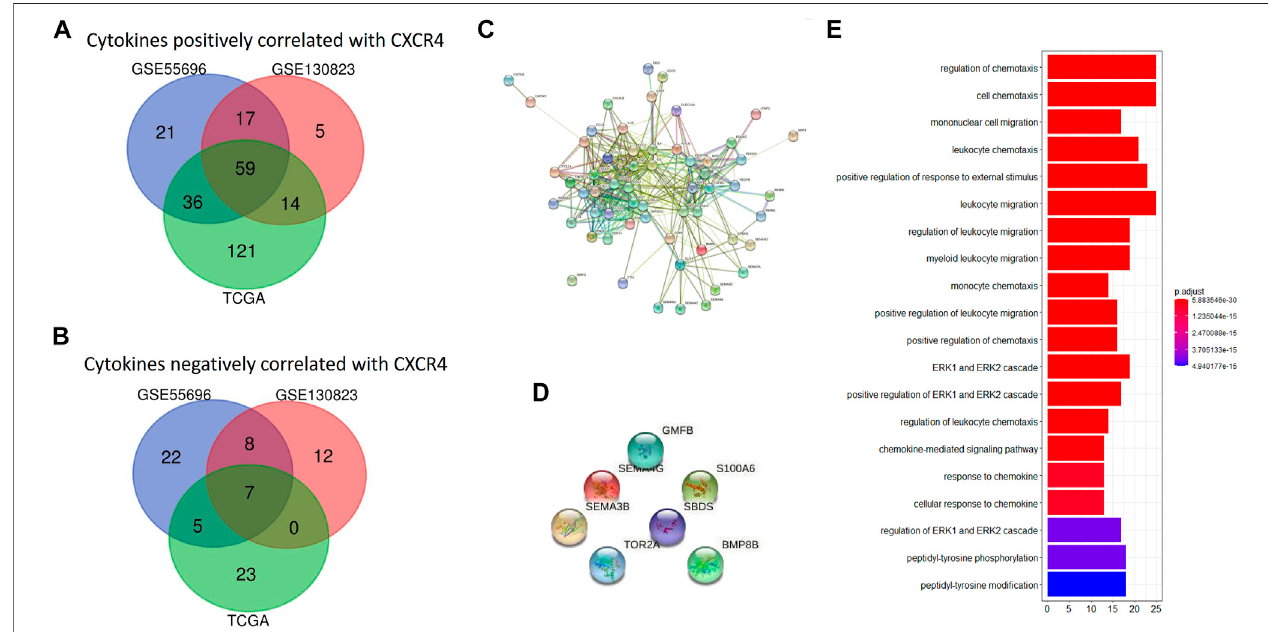
FIGURE5| CXCR4co-expressioncytokines. (A) Venndiagramshowing59sharedcytokinespositivelycorrelatedwithCXCR4fromGSE55696,GSE130823,and TCGAcohorts. (B) VenndiagramshowingsevensharedcytokinesnegativelycorrelatedwithCXCR4fromGSE55696,GSE130823,andTCGAcohorts. (C) PPInetwork ofthe19genespositivelycorrelatedwithCXCR4. (D) PPInetworkshowednointeractionbetweensevencytokinesnegatively correlatedwithCXCR4. (E) ResultsofGO enrichment of the 59 cytokines positively correlated with CXCR4.